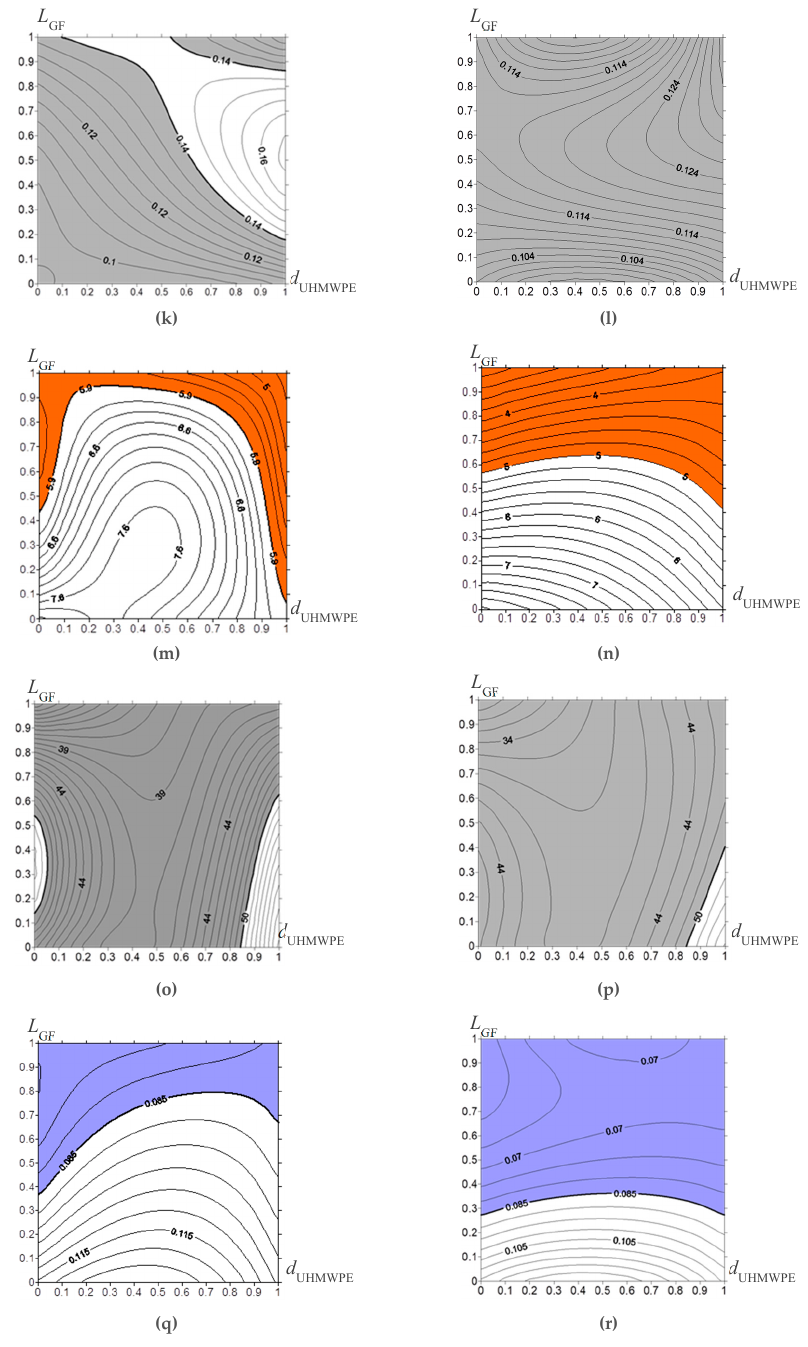
Figure 13. Isoline patterns on operational properties of the UHMWPE-based samples vs. particle sizes of the initial powders and length of the glass fibers without treatment ( a , c , e , g , i , k , m , o , q ) and after the treatment with “KH-550” ( b , d , f , h , j , l , n , p , r ): impact strength ak, kJ / m ( a , b ); tensile elastic modulus E, MPa ( c , d ); yield tensile strength σ t, MPa ( e , f ); ultimate tensile strength σ U, MPa ( g , h ); elongation at break ε , % ( i , j ); the friction coe ffi cient f ( k , l ); the wear rate at 60 N × 0.3 m / s I, 10 − 5 mm 3 / h ( m , n ); the wear rate at 140 N × 0.5 m / s I, 10 − 5 mm 3 / h ( o , p ), the abrasive wear rate I, mm 3 / m ( r , q